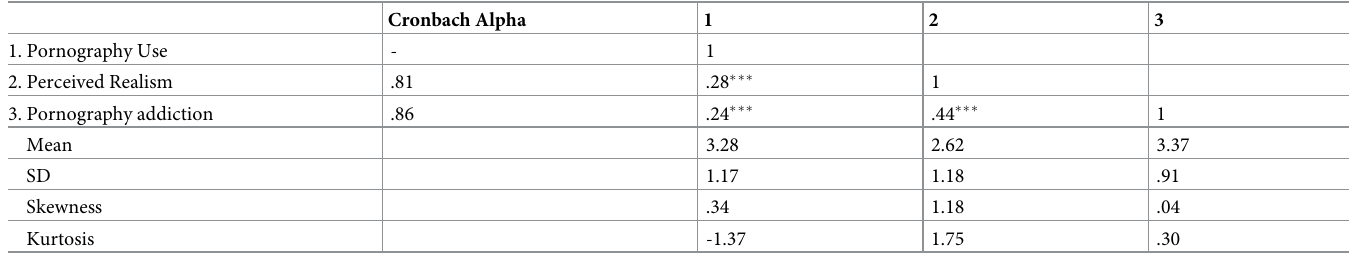
Table 1. Cronbach alpha reliability, descriptive and matric correlation between variables ( n = 222).